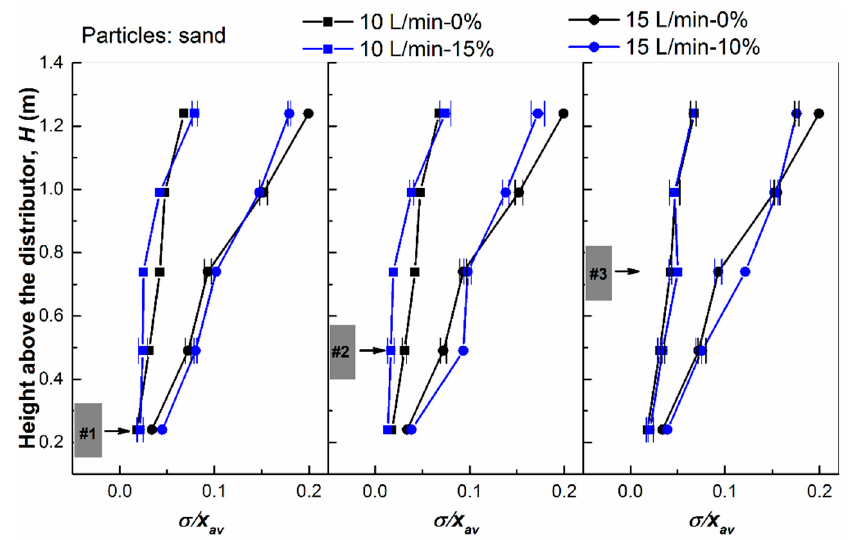
Figure 13. Effects of gas extraction on the σ r of the differential pressure signals with individually activated membrane #1-3 for gas extraction. The other operation conditions were: T = 550 °C, P = 0.1 MPa, H ini = 1.28 m, U = 0.09~0.14m/s, extraction rate = 1.5 L/min, silica sand.